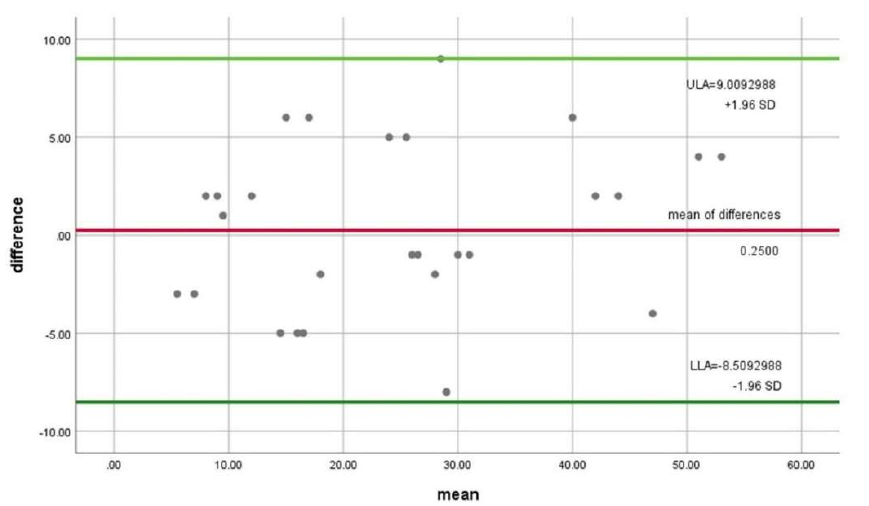
digital and manual technique in the 28 study Figure 5. Bland-Altman plot of agreement between results obtained from discrepancy index by dig- ital and manual technique in the 28 study patients.